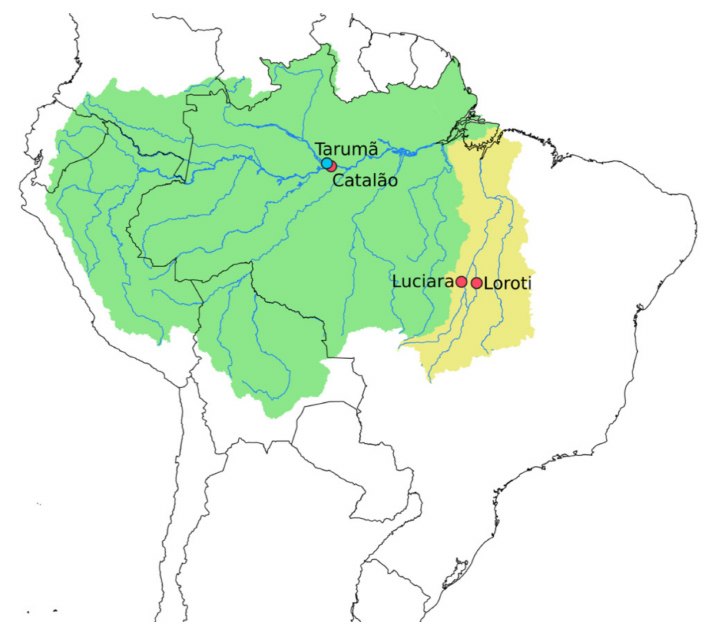
Figure 1. Map of Brazil and neighboring countries showing sampling sites for Osteoglossum bicirrhossum (red dots) and O. ferreirai (blue dot) from Amazon (green) and Tocantins-Araguaia (yellow) river basins. Table1. Collectionsitesofthearowanaspeciesanalyzed, withthecorrespondingnumbersofindividuals used for single nucleotide polymorphisms (SNP - DArT_N) and cytogenetic analyses (Cito_N). Species Sampling Site River Basin Osteoglossum bicirrhosum Java é River (Loroti,